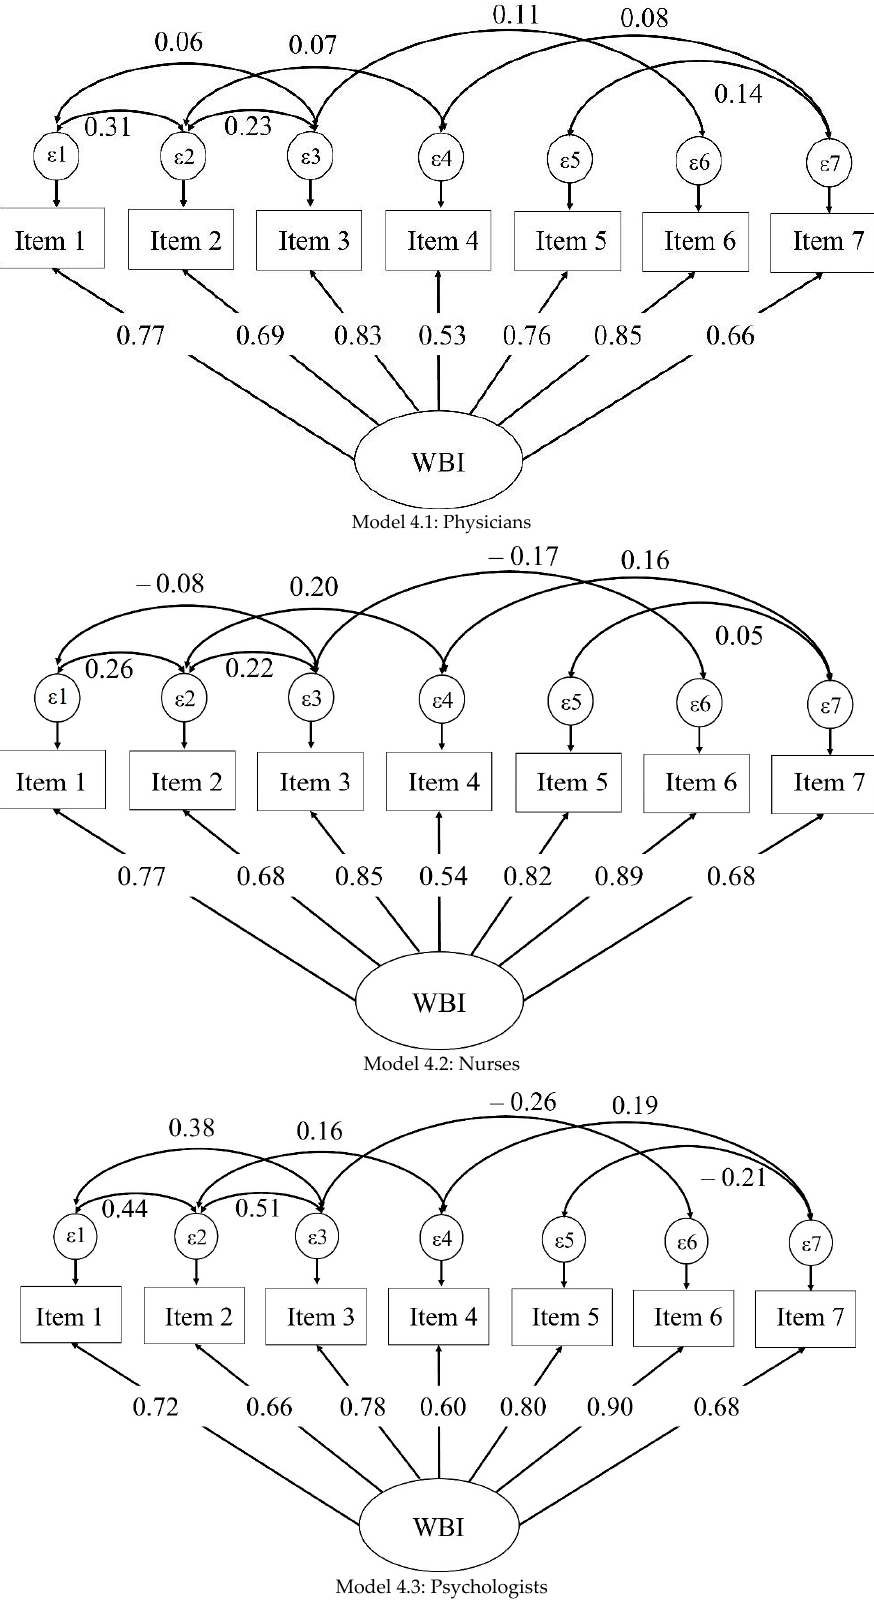
Model 4.3: Psychologists Factor loadings and residual covariances are standardized values. Figure 2. Multigroup confirmatory factor analysis: physicians ( Model 4.1 ), nurses ( Model 4.2 ), and psychologists ( Model 4.3